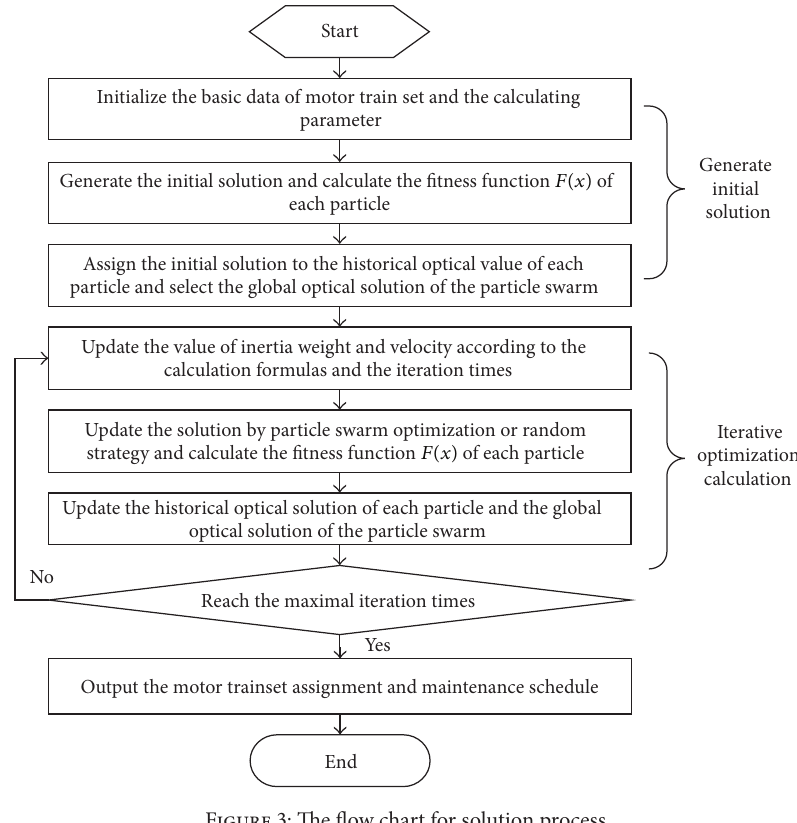
Figure 3: The flow chart for solution